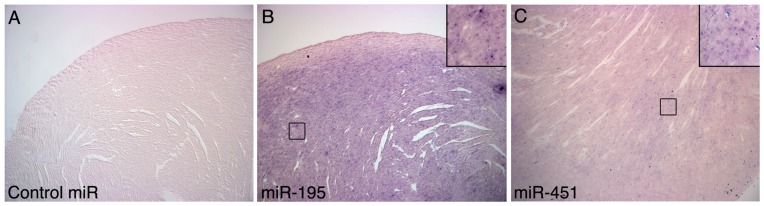

In situ hybridization of miR-195 and miR-451 expression in R403Q HCM hearts.In situ hybridization of miR-195 and miR-451 in the left ventricle of male R403Q HCM hearts. 5′ digoxin-conjugated LNA-modified DNA probes complementary to mature miR-195 or -451 were used to detect native miR-195 and -451. Panel A (100X magnification): Scrambled sequence, missense 5′ digoxin-conjugated LNA-modified DNA probe; Panel B (100X magnification): miR-195, 5′ digoxin-conjugated LNA-modified miR-195 sequence probe; Panel C (100X magnification): miR-451, 5′ digoxin-conjugated LNA-modified miR-451 sequence probe. Insets: 200 X magnification. No significant signal was detected in hearts probed with the scrambled sequence. Sections treated with probes specific for miR-195 or miR-451 demonstrated a detectable signal.